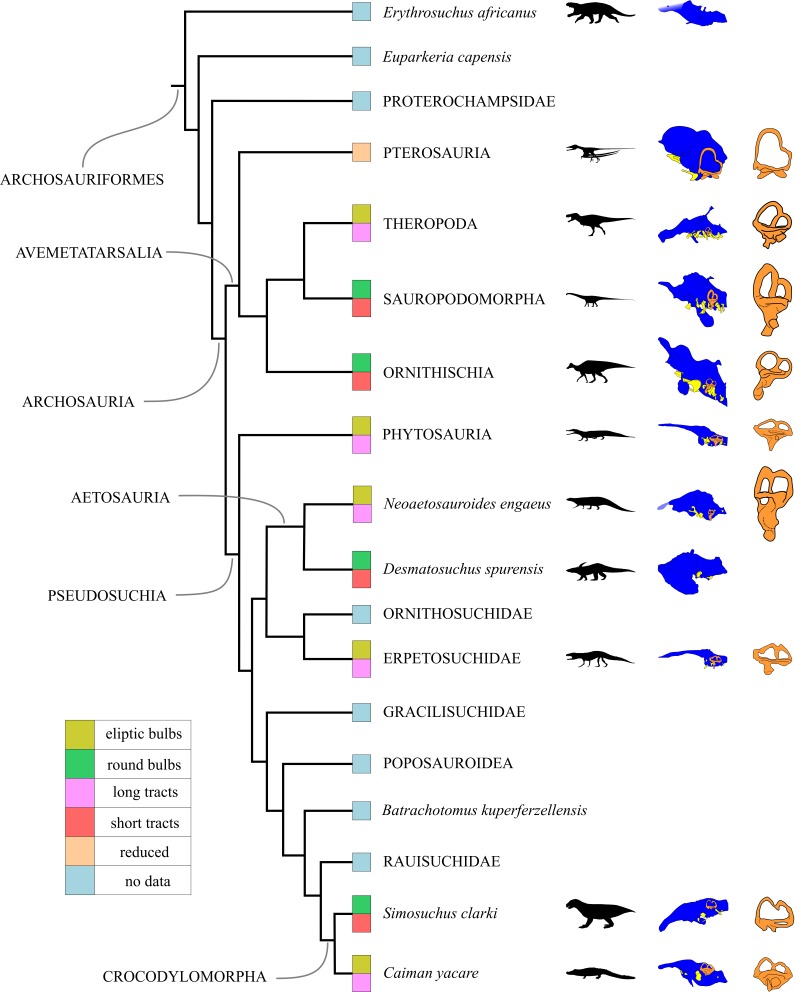
Endocranial anatomy of several archosauriform taxa and their phylogenetic relationship (phylogeny modified from Ezcurra et al., 2017).Life reconstructions of selected archosauriforms in black, encephalon in blue (not to scale), vestibular apparatus in orange, and cranial nerves in yellow. Olfactory region features plotted on the phylogeny, see references within figure. Archosauriform endocasts redrawn from Gower & Sennikov, 1996 (archosauriforms Erythrosuchus africanus); Witmer et al., 2003 (pterosaur Anhanguera santanae); Witmer & Ridgely, 2008 (theropod Tyrannosaurus rex and sauropod D. longus); Evans, Ridgely & Witmer, 2009 (ornithischian H. altispinus); Lautenschlager & Butler, 2016 (phytosaur P. angustifrons); Hopson, 1979 (aetosaur D. spurensis); Nesbitt et al., 2018 (erpetosuchid P. gracilis); Kley et al., 2010 (crocodylomorph S. clarki); MACN-HE 43694 (crocodilian C. yacare).